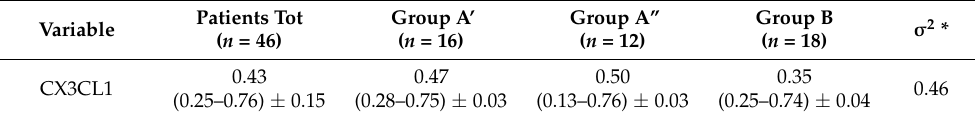
Figure 5. CX3CL1 in the CSF of subjects belonging to Groups A’, A”, and B. Group A’ is depicted in light gray, Group A” is depicted in medium gray, and Group B is depicted in dark gray. Table 5. Average values recorded for CX3CL1. The minimum and maximum values are shown in parentheses; σ 2 is the variance of the values according to “one-way